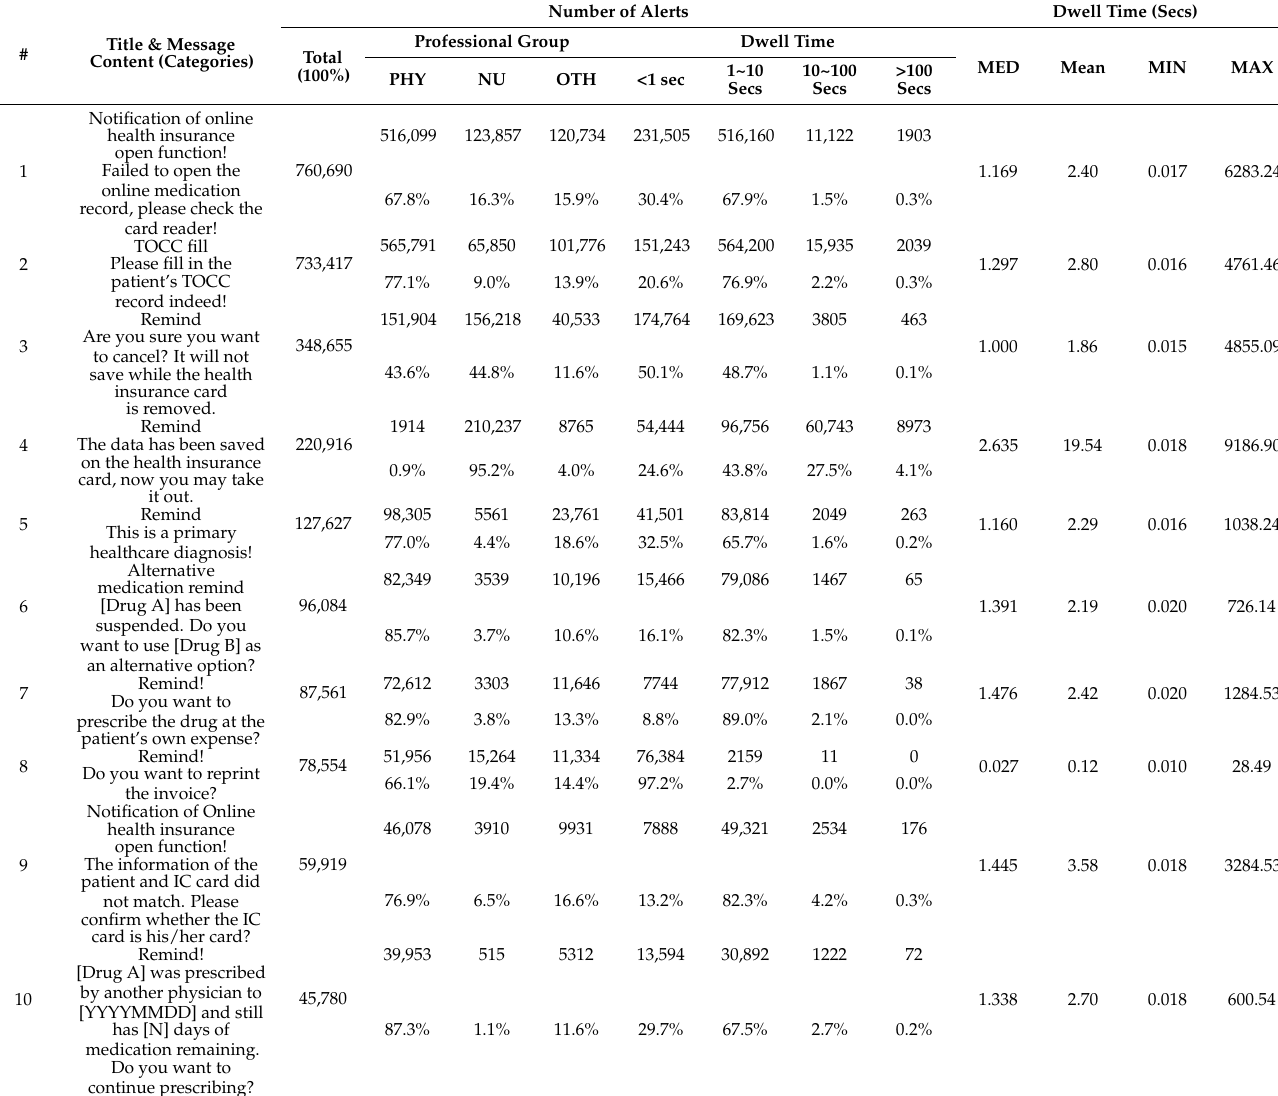
Table 2. Different alert characteristics for the top 10 categories of alert message